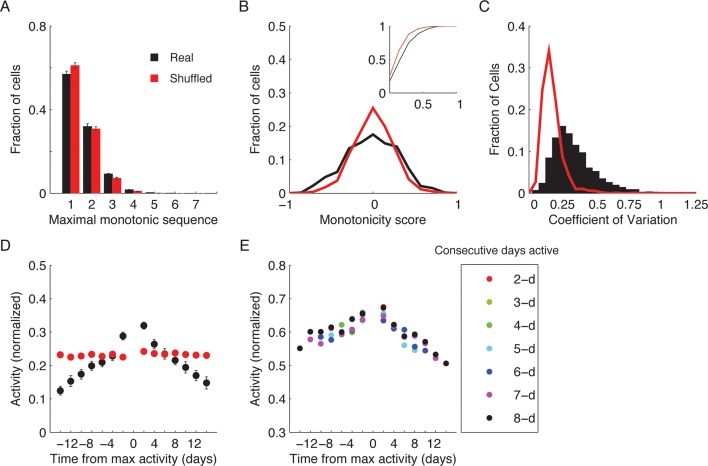
Within-environment cell-level dynamics (A–E).(A) Distribution of maximal monotonic sequence length for all cells (black) and for the shuffled data (red). None of the cells exhibited monotonic changes in event rates throughout the experiment (0.7% of cells with a monotonic sequence-length ≥ 4). However, the single-cell dynamics were slightly more monotonic than shuffled data (average maximal sequence length is 1.56 for real data and 1.48 for shuffled data). Data are mean ± s.e.m. (B) Distribution of the monotonicity score. Inset, cumulative distribution of the absolute values of the score for all cells. In the real data (black) there were more strongly increasing and decreasing cells than in the shuffled data (red) suggesting that cell-level changes in event rates are time dependent and are not purely due to noise (Kolmogorov-Smirnov test, p < 10−10). (C) Distribution of event rates’ coefficient of variation (CV) for the cells that were active in all sessions (black) and the CV distribution of a population of simulated cells with equivalent average event rates that follow a stationary Poisson model of activity (red). Note that cells exhibit higher CV than Poisson distribution (median CV is 0.30 for real data and 0.16 for the equivalent Poisson model) indicating that even cells that were active in all days of the experiment do not preserve their firing rates over days. (D,E) Gradual ensemble dynamics emerges when averaging the activity over the entire population. (D) Normalized event rate aligned to the day of peak event rate, averaged over all cells. The real data (black) shows a clear relationship between the ensemble average event rate and time difference from the session with the maximal event rate. Data are mean ± s.e.m. Shuffled data shown in red. (E) Same as in D for subgroups of different maximal consecutive activity segment lengths (2–8 days, maximal-length active segment is shown). Thus, the trend shown in D is not only due to the recruitment dynamics but also due to gradual changes in event rates of active cells.